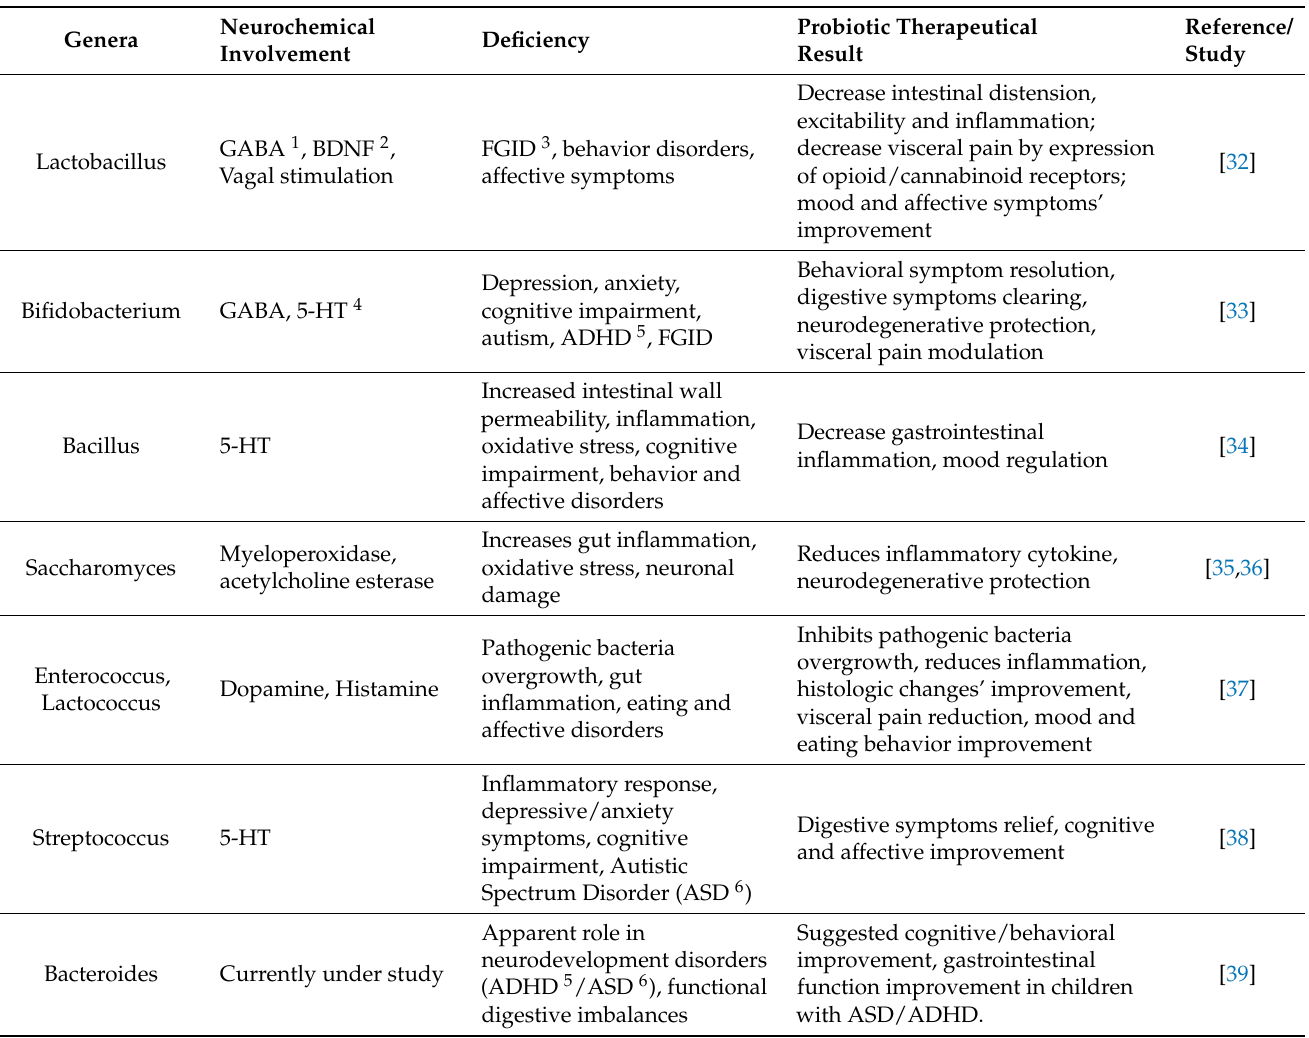
Table 1. Main bacterial genera involved in modulation of the gut–brain axis and possible candidates as combinative therapy alongside magnesium